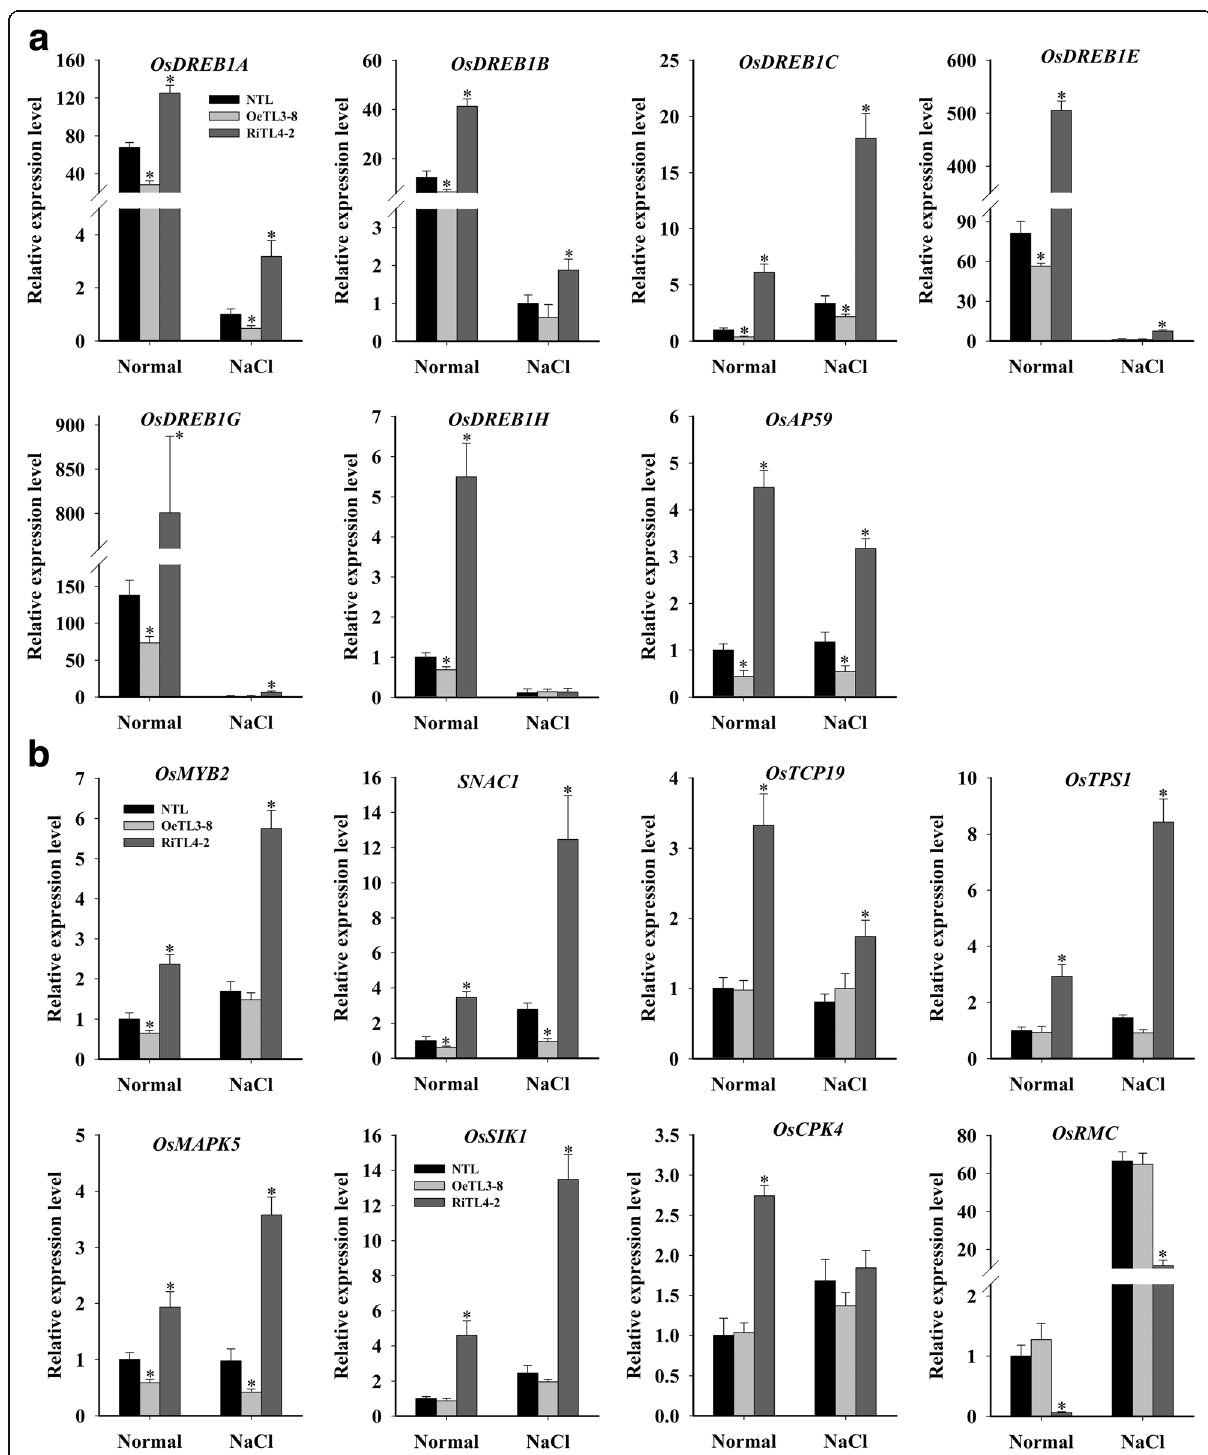
Fig. 6 OsRACK1A regulates the expression of stress-related genes. Expression of stress-related AP2/ERF genes ( a ) and other stress-related genes ( b ) in OeTL3 – 8 and RiTL4 – 2 compared with the NTL in both normal and salt-stress (150 mM NaCl for 24 h) conditions by qRT-PCR. Data shown are the means ± SE of four biological replicates. An asterisk indicates a significant difference ( P < 0.05) versus stressed